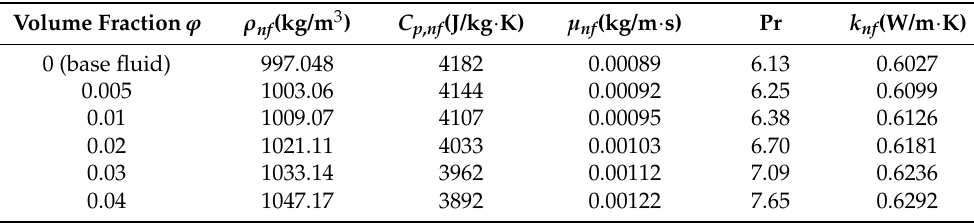
Table 3. Effective thermo-physical parameters of the nanofluid under normal circumstances. Volume Fraction